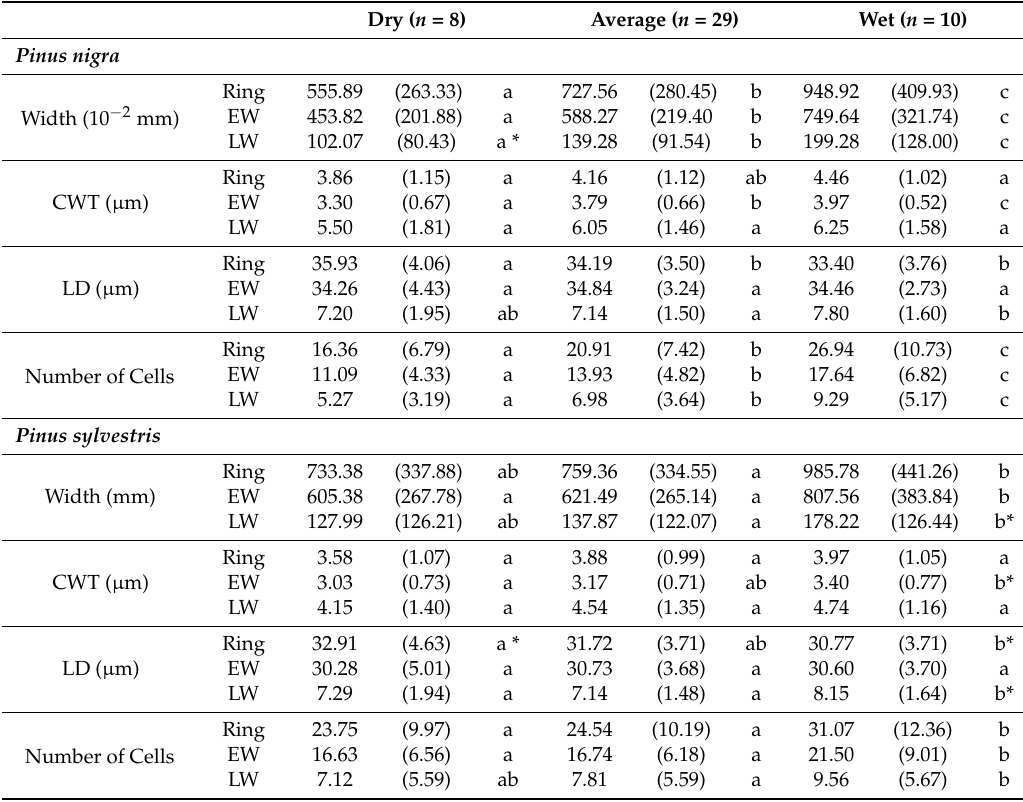
Figure 6. Mean intrinsic water use efficiency (iWUE) for dry, average, and wet years. Each point is the mean of values for three years in five trees per species. Error bars represent the standard error of the mean.